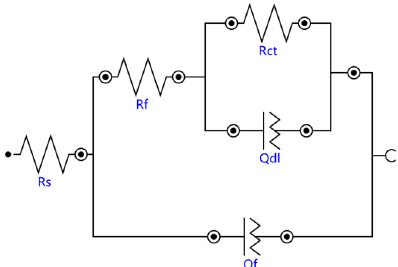
Figure 12. Equivalent circuit model of the substrate and cermet coatings.